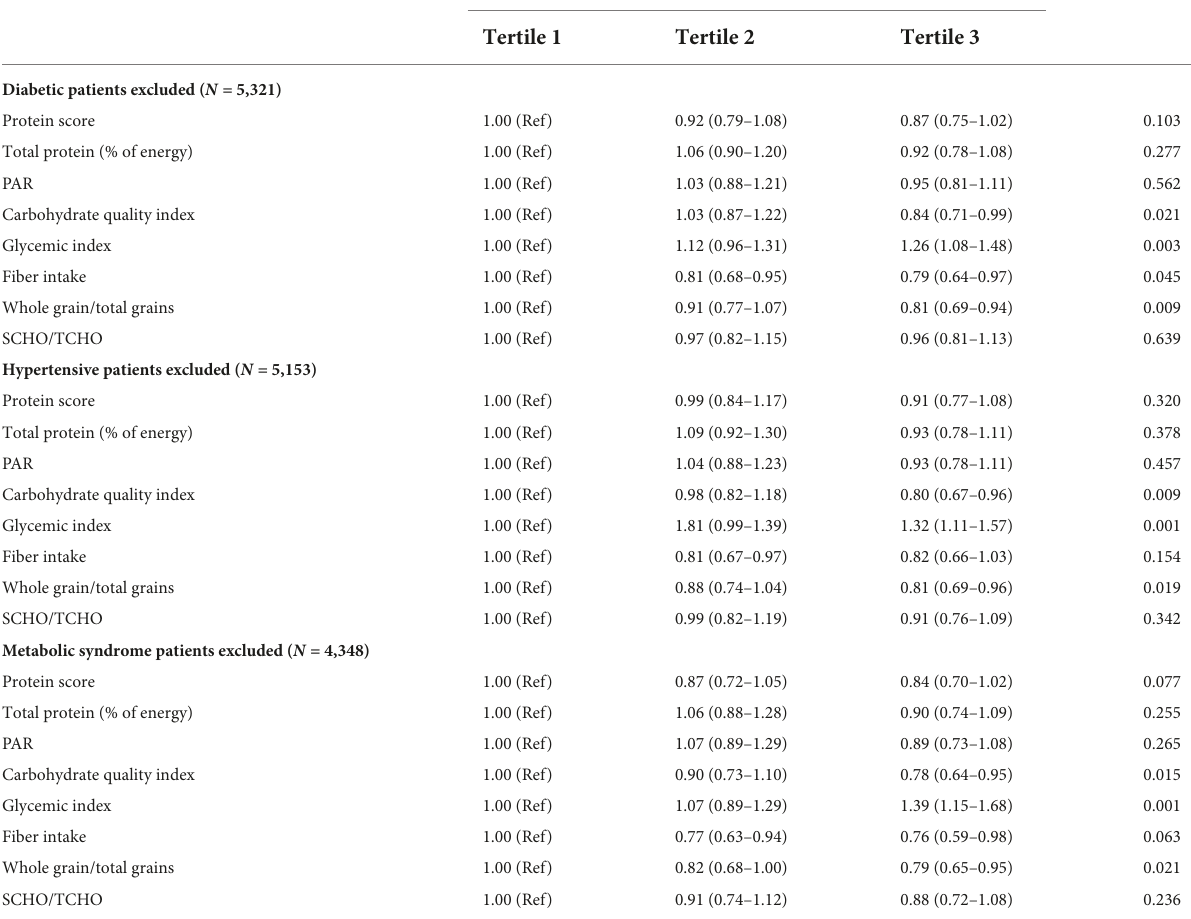
TABLE 5 The association of protein score, carbohydrate quality index score, and their components with risk of chronic kidney disease. Hazard ratios (95% confidence intervals) P trend * Tertile 1 Tertile 2 Tertile